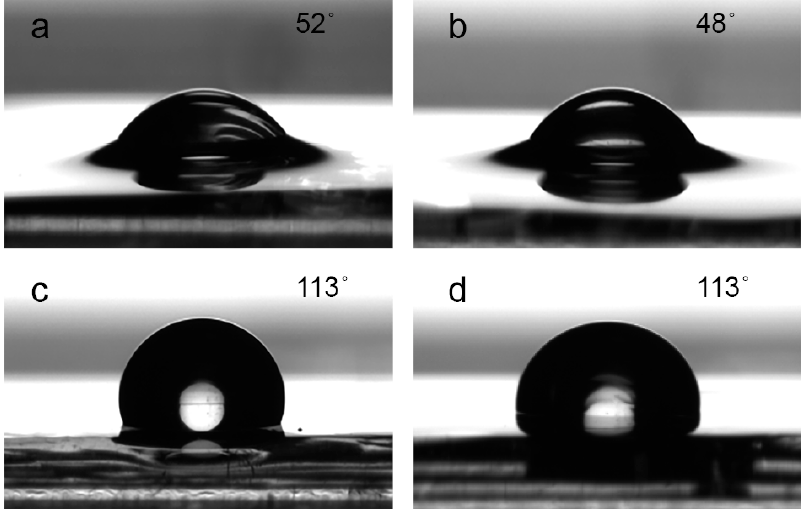
Figure 4. The contact angle of ink drops on PDMS surface cured for ( a ) 0, ( b ) 3, ( c ) 5, and ( d ) 7 min.